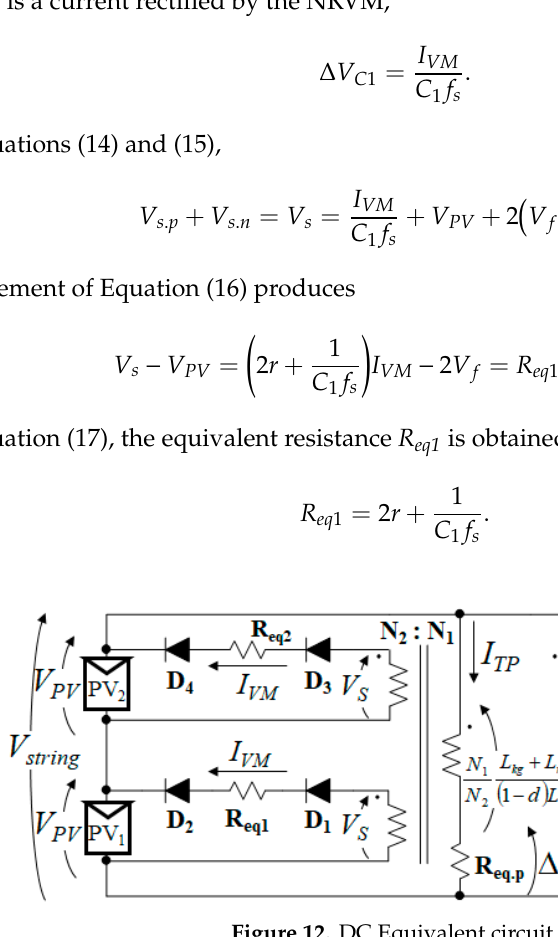
Figure 12. DC Equivalent circuit.